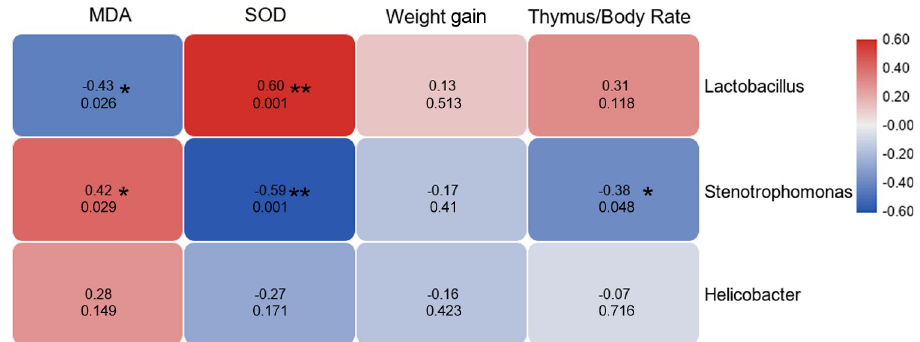
Fig 5. Correlation analysis results. Correlation analysis results among the abundance of dominant bacteria and physiological indicators. The redder the color, the stronger the positive correlation, and the bluer the color, the stronger the negative correlation. The numbers in cells indicate the correlation coefficient (upper) and p value (bottom). SOD: Superoxide dismutase; MDA: Malondialdehyde.